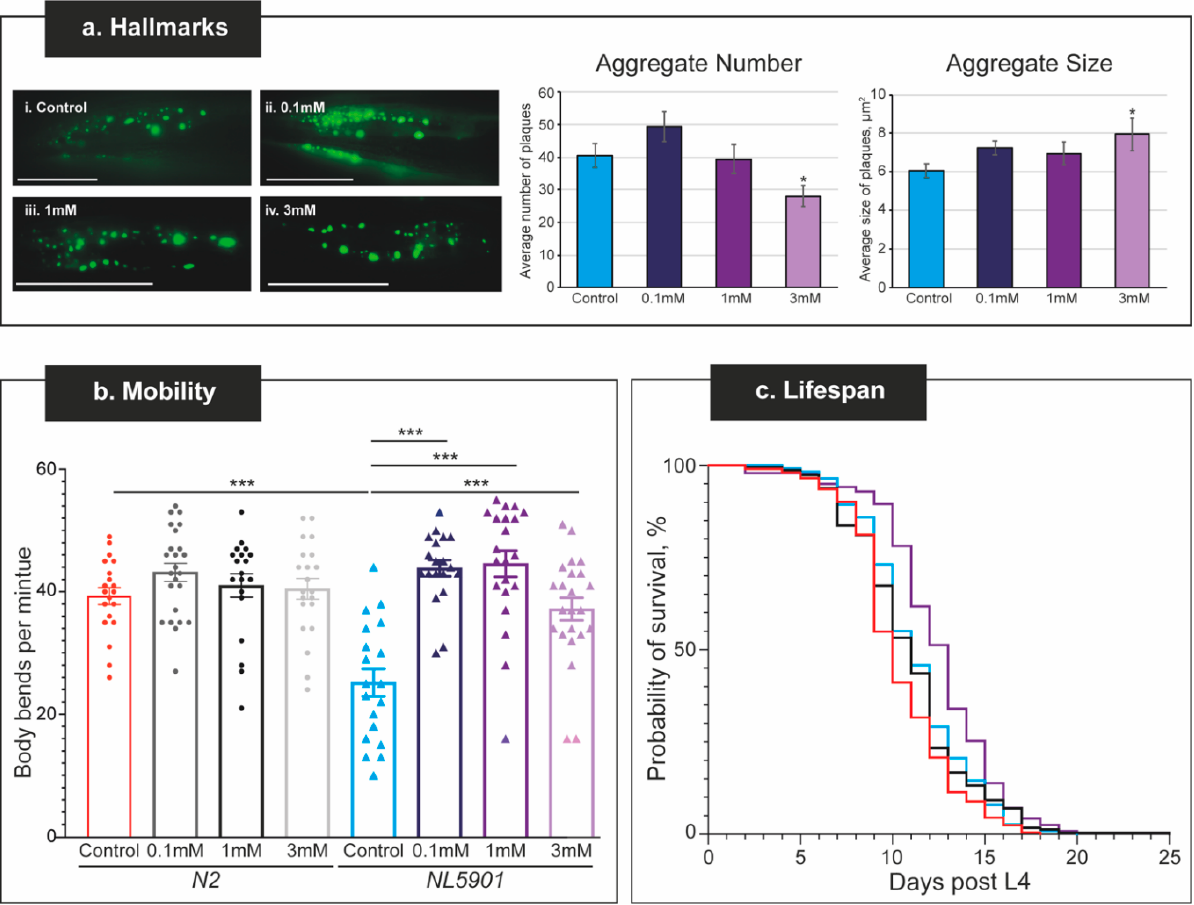
Figure 4. The dose–response curve for Levodopa on thrashing and α -synuclein aggregates. ( a ) Hall- marks of the Parkinson’s Disease shown by the α -synuclein aggregates. Representative Zeiss